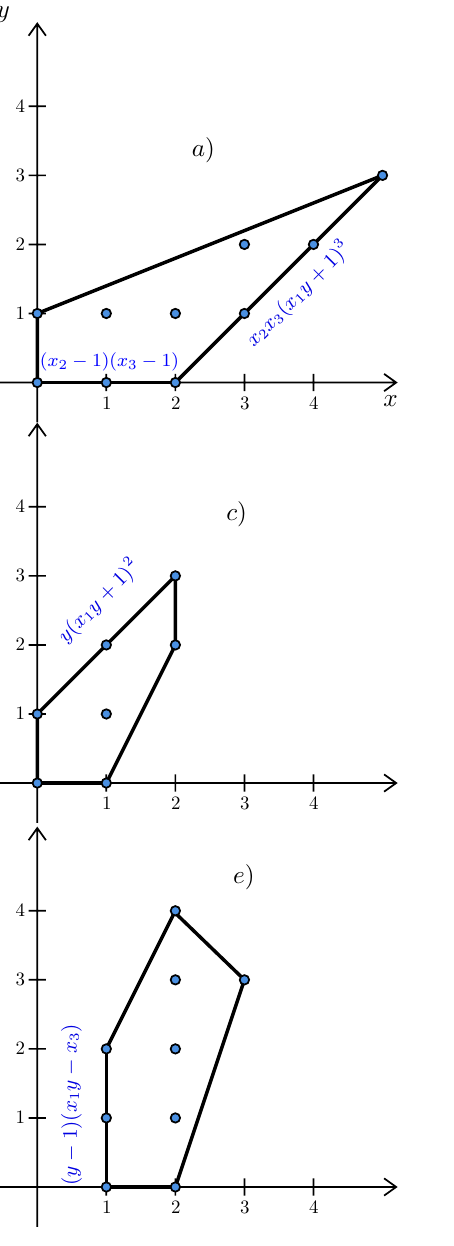
Figure 28 . Newton polygons and face polynomials for the examples a ) ; b ) ; c ) ; d ) ; e